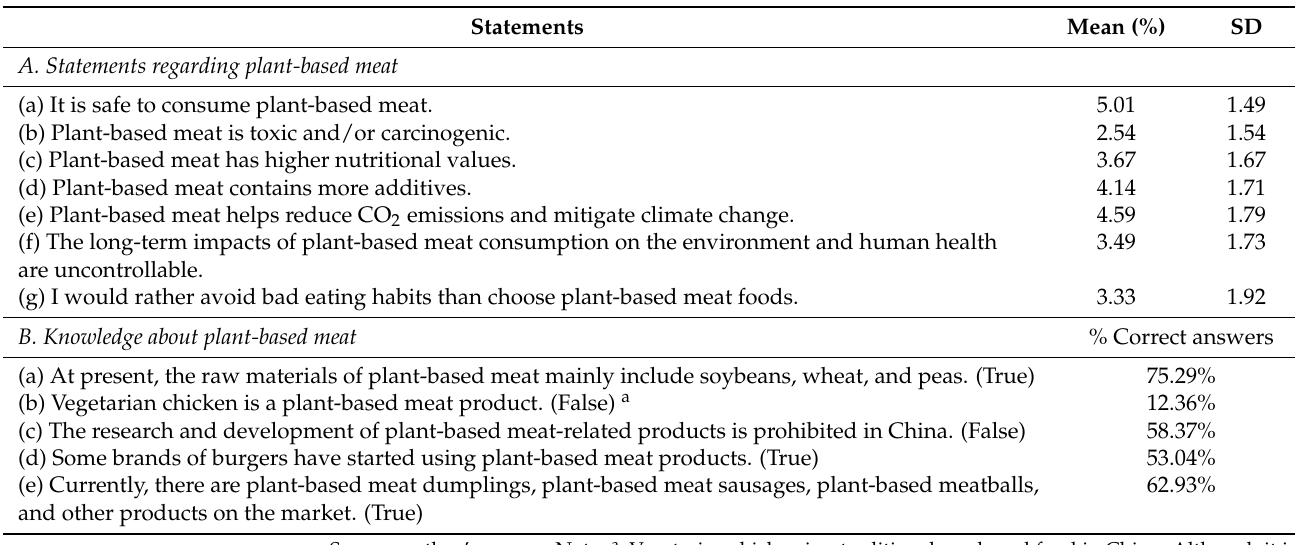
Table 3. Consumer perceptions of and knowledge about plant-based